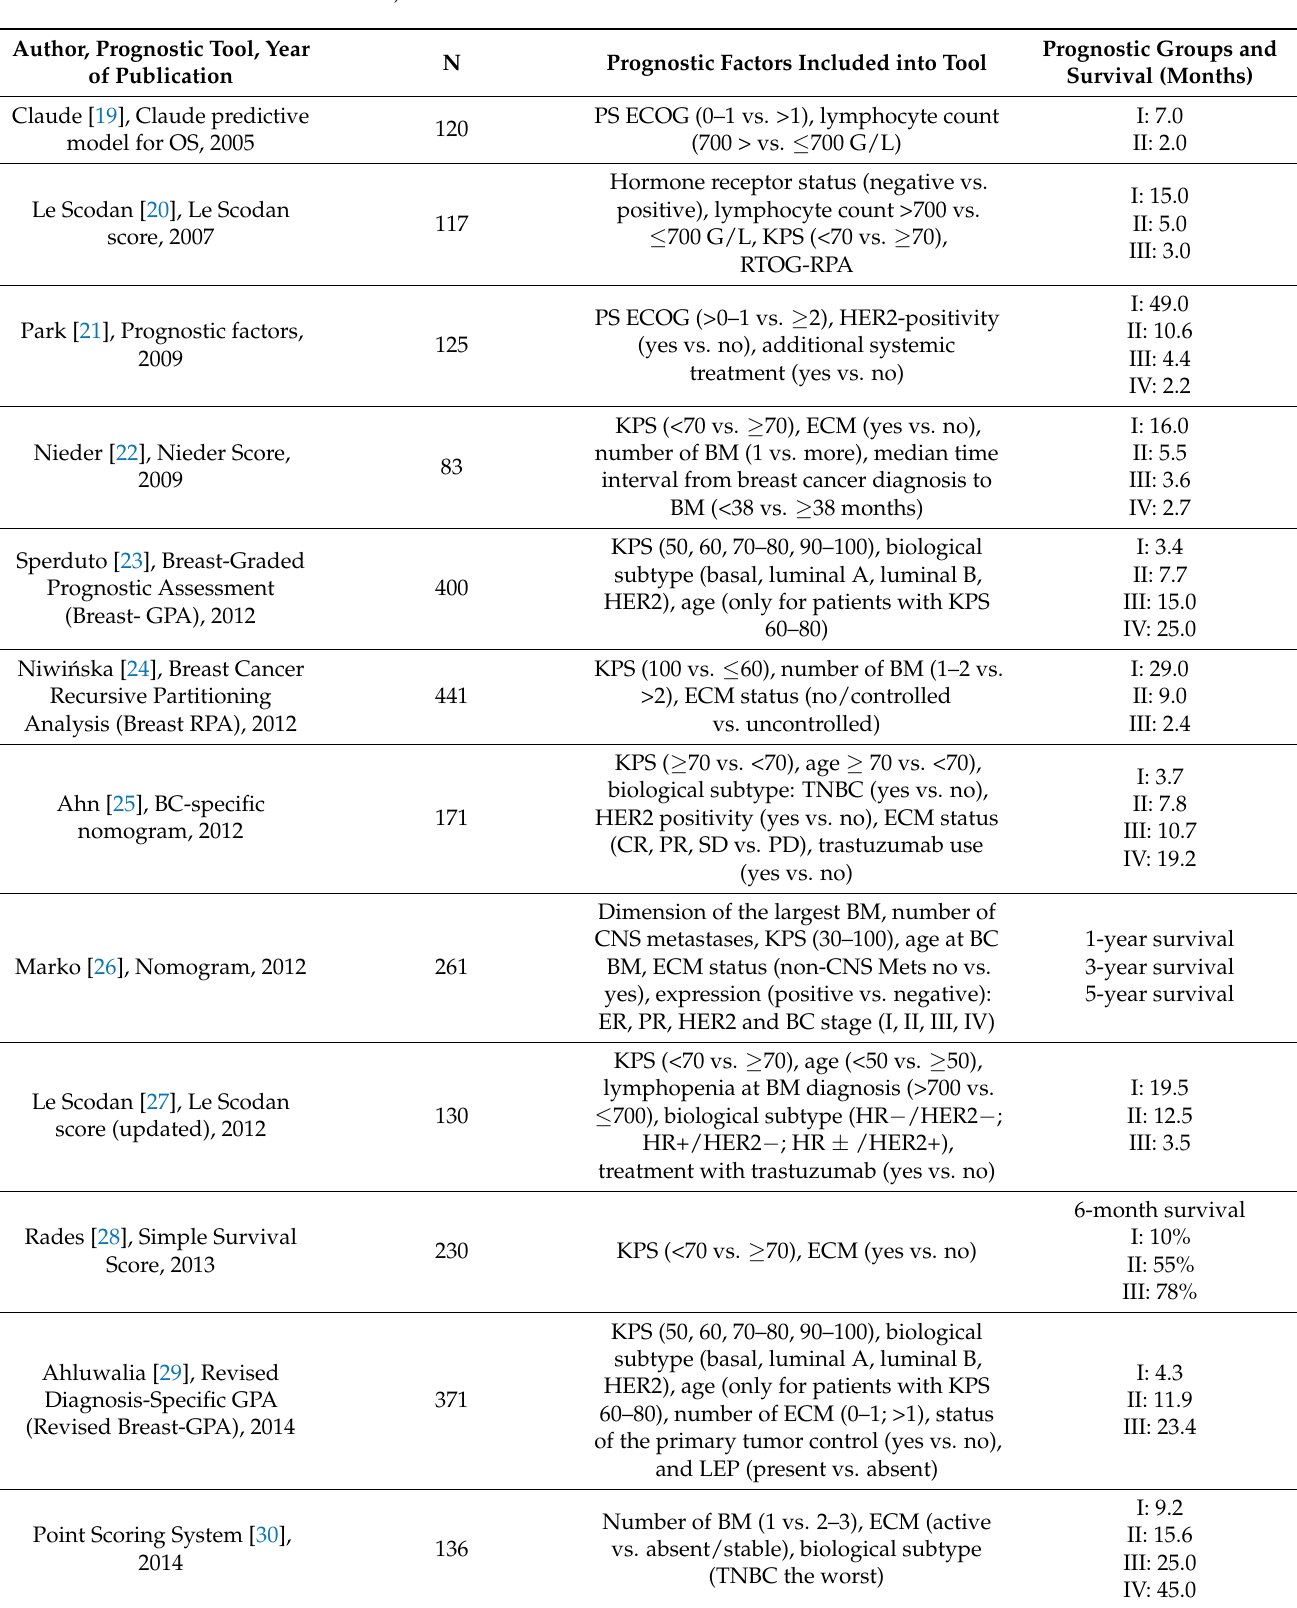
Table 2. Prognostic tools developed on breast cancer patients with brain metastases (from year 2005 to